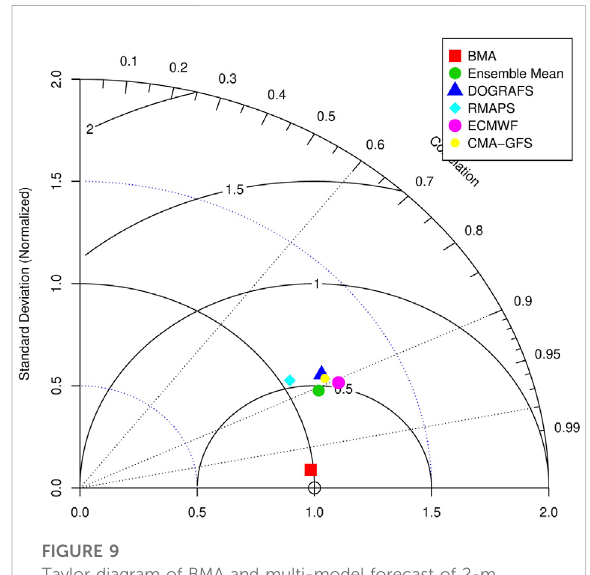
FIGURE 9 Taylor diagram of BMA and multi-model forecast of 2-m temperature during the forecast